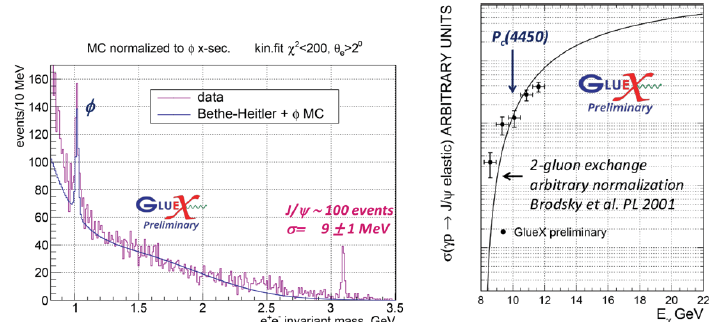
Figure 6: (Left) The invariant mass of e + e − showing a clear signal at the J /ψ mass, using only a small subset of the data collected by GlueX. (Right) The elastic cross-section of γ p → J /ψ in arbitrary